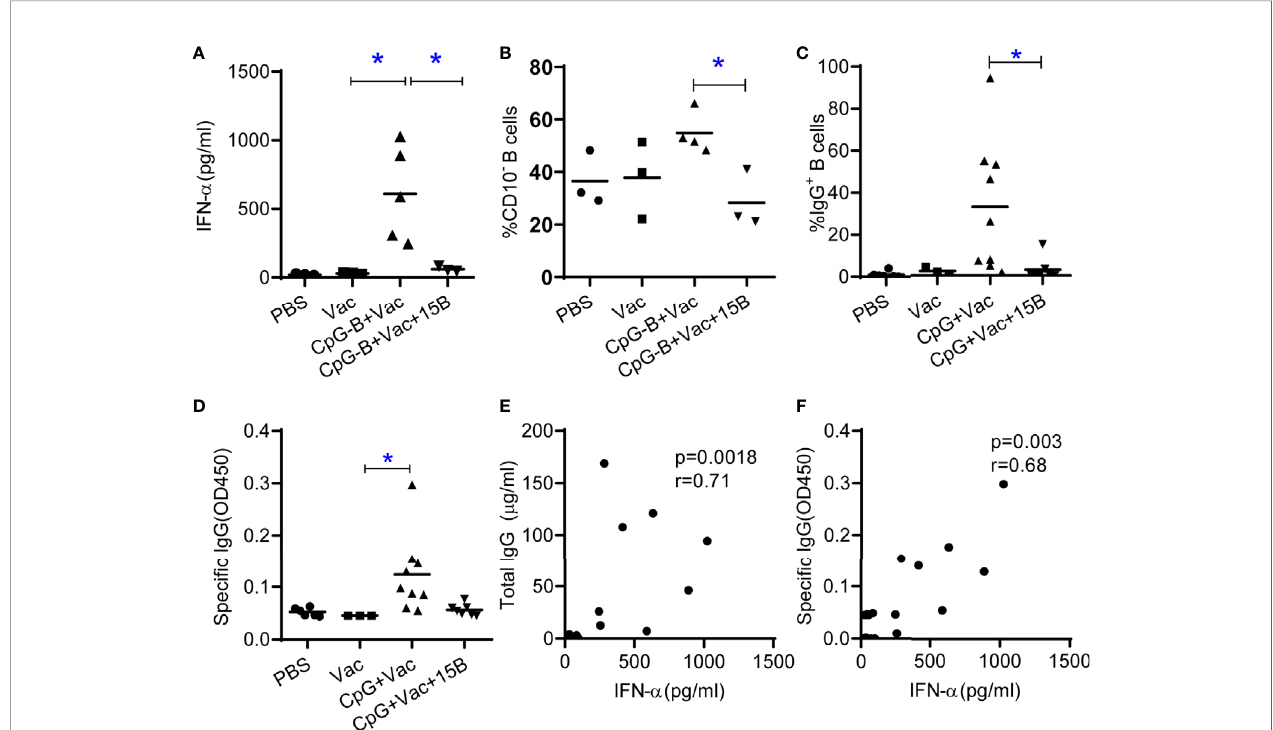
FIGURE 4 | TLR9 and CD40-targeting vaccination depends on pDC to promote human B cell maturation and IgG induction in humanized mice. Humanized mice were vaccinated as in Figure1 except one group of the mice were treated with pDC depletion Ab before vaccination (A) IFN- a in the plasma 24 hours after vaccination. (B) Expression of CD10 on B cells from spleen at termination. (C) Total IgG level in serum was detected by ELISA. (D) Antigen speci fi c IgG level in the plasma was detected by ELISA. Each dot represents one individual mouse, bars indicate mean. Shown are representative data (PBS, n=3; Vac, n=3; CpG-B+Vac, n=4; CpG+Vac+15B, n=3, for A and B) or combined data (PBS, n=6; Vac, n=3; CpG-B+Vac, n=9; CpG+Vac+15B, n=7, for C and D) of two independent experiments with mean values. *P < 0.05, by one-way analysis of variance (ANOVA) and Tukey ’ s multiple comparisons test. (E, F) Correlation analysis between the IFN- a levels in plasma and total IgG (E) and speci fi c IgG (F) levels in plasma (Spearman rank correlation test). r, correlation coef fi